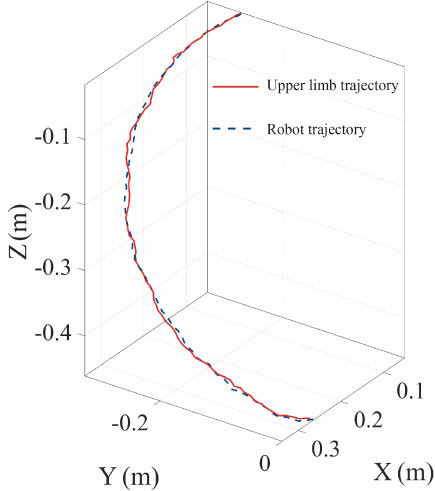
Figure 6. The upper limb trajectories and the robot trajectories in the smooth pursuit movement tests.